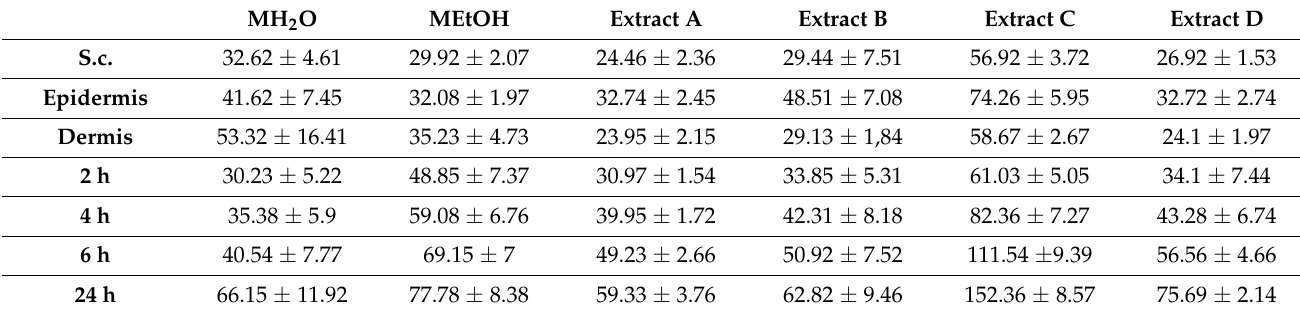
Table 3. Accumulation of mangiferin analysed by HPLC-UV among skin layers: stratum corneum, epidermis, and dermis, and mangiferin permeation through the skin after 2, 4, 6, and 24 h (ng/cm 2 ) from the application of mangiferin solutions (MH 2 O, MEtOH) or honeybush extracts (A, B, C, D).